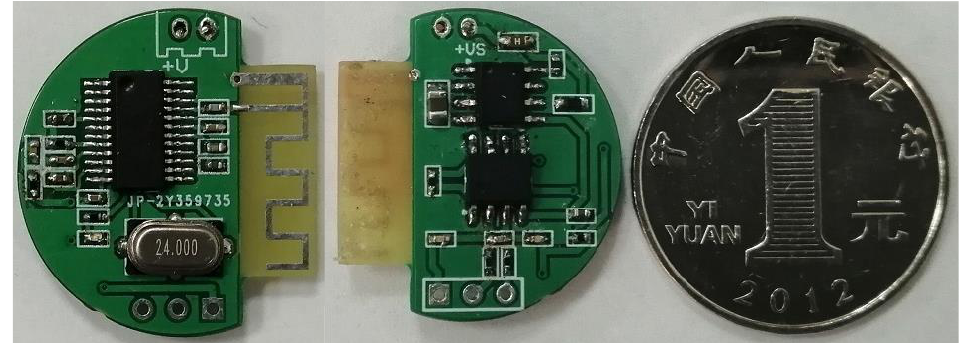
Figure 4. Collection circuit of the portable wireless fetal sound monitoring system.